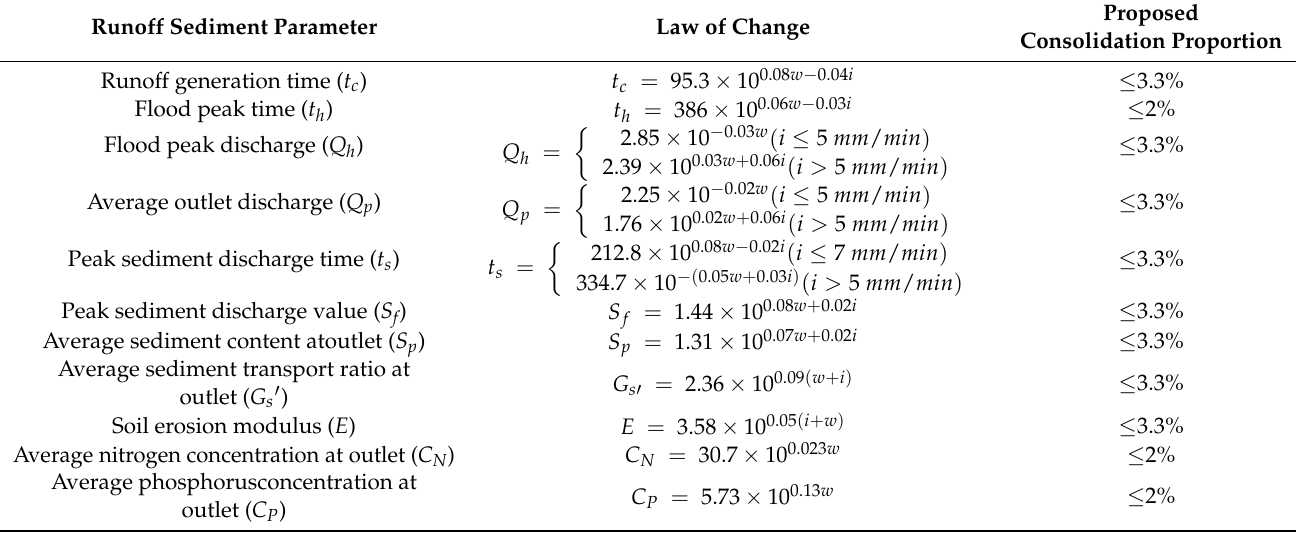
Table 5. Changes in the small watershed erosion and transport parameters and the recommended consolidation proportion.